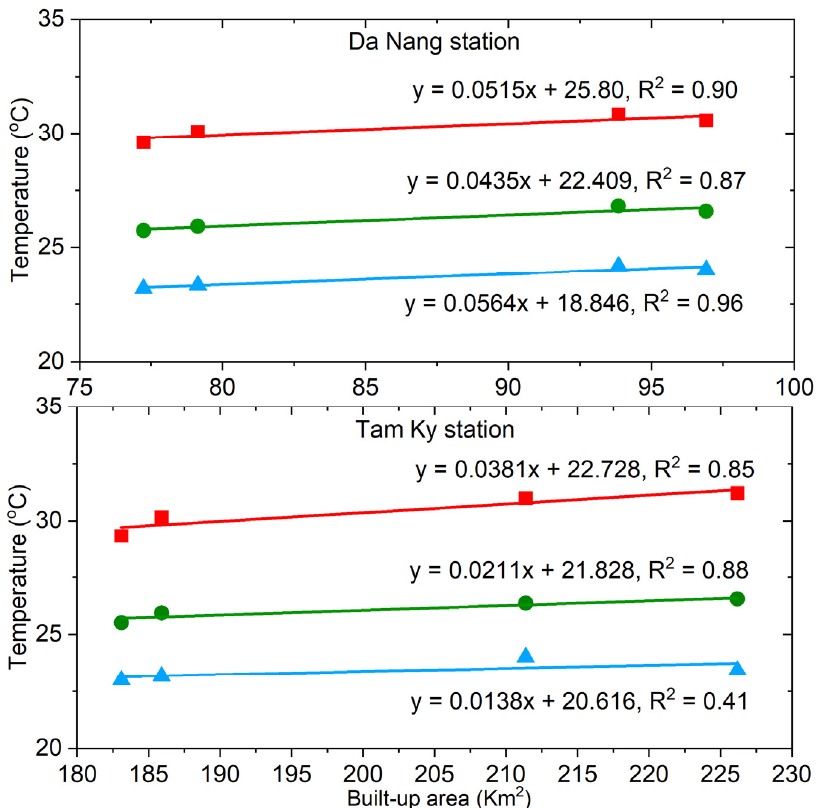
Figure 10. The correlation between the UHI and built-up area in 2000, 2005, 2010, and 2020 at the Da Nang and Tam Ky meteorological stations for Da Nang city and Quang Nam province, respectively.